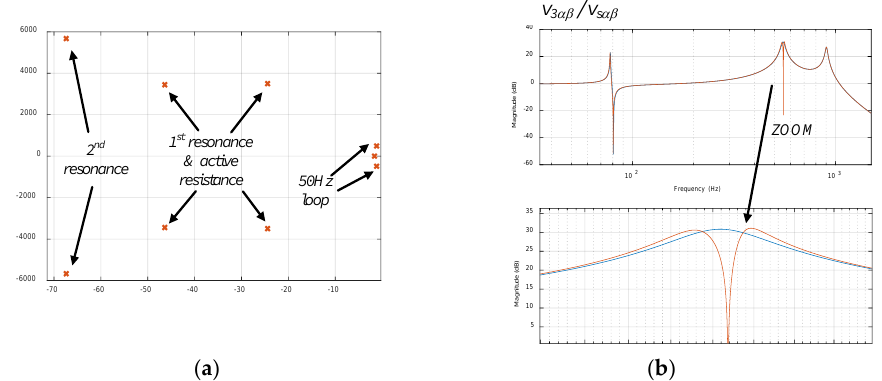
Figure 10. Dominant poles and Bode plots of the voltage at the Pcc with active resistance R v 1 = 7.562 k Ω (2.5 Ω at the low voltage side) programmed at 550 Hz. ( a ) Dominant poles of the system, ( b ) Bode plot of v 3 αβ ( s )/ v sαβ ( s ) .